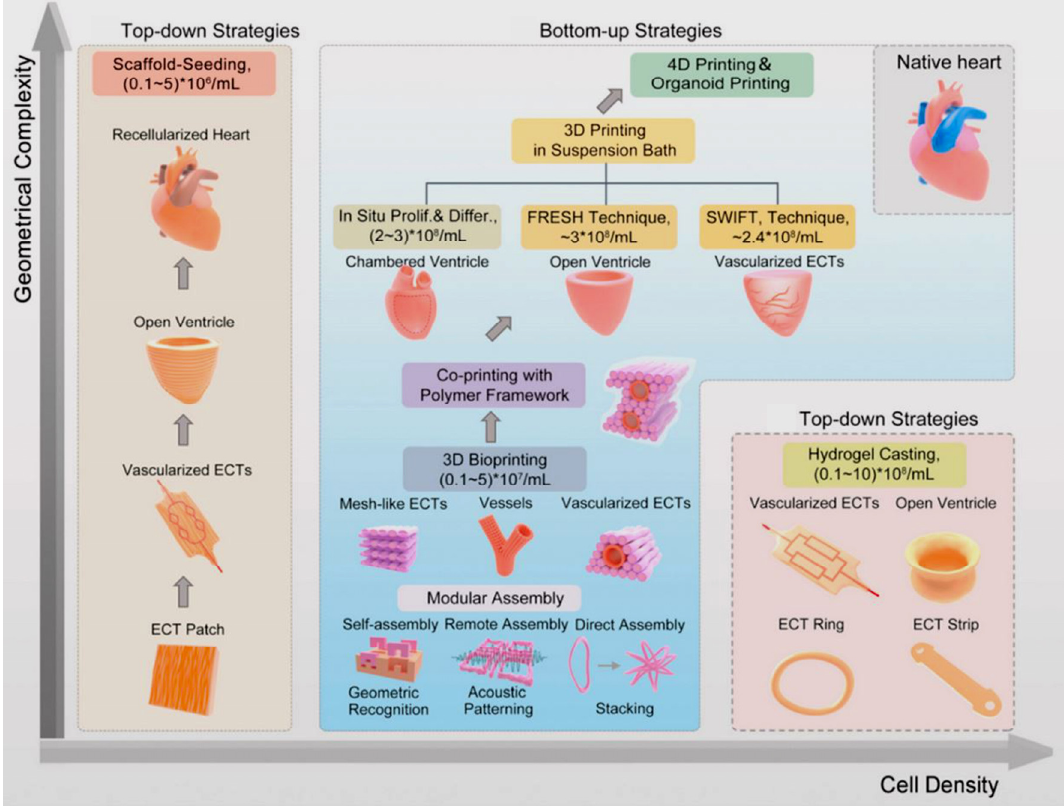
Figure 10. Bioengineering approaches for in vitro generation of cardiac tissue in terms of their ability to achieve the geometrical complexity and physiological cell density of the native heart [75].